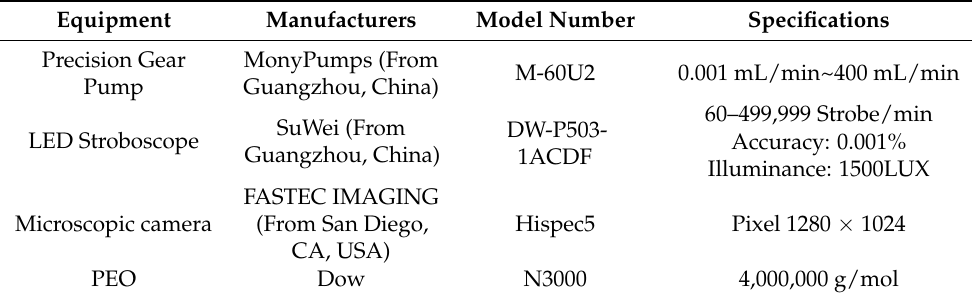
Table 1. Specifications of Centrifugal Stroboscopic Observation Platform Components.